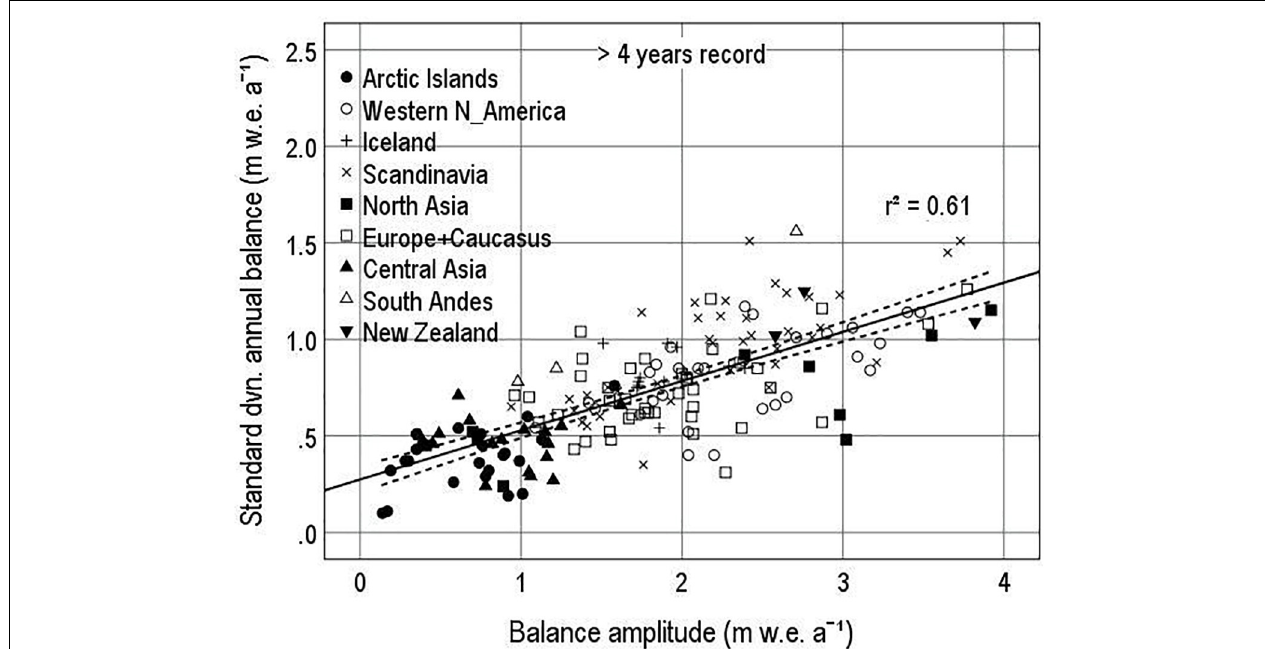
FIGURE 5 | Standard deviation of annual balance vs. balance amplitude for glaciers > 4 years of record in 1946–2015.